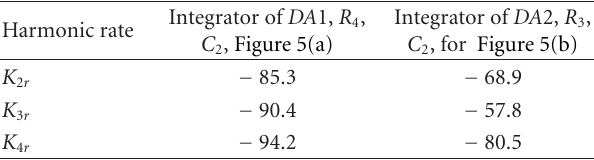
Table 1: Comparison of integrators for higher harmonic level, dB.